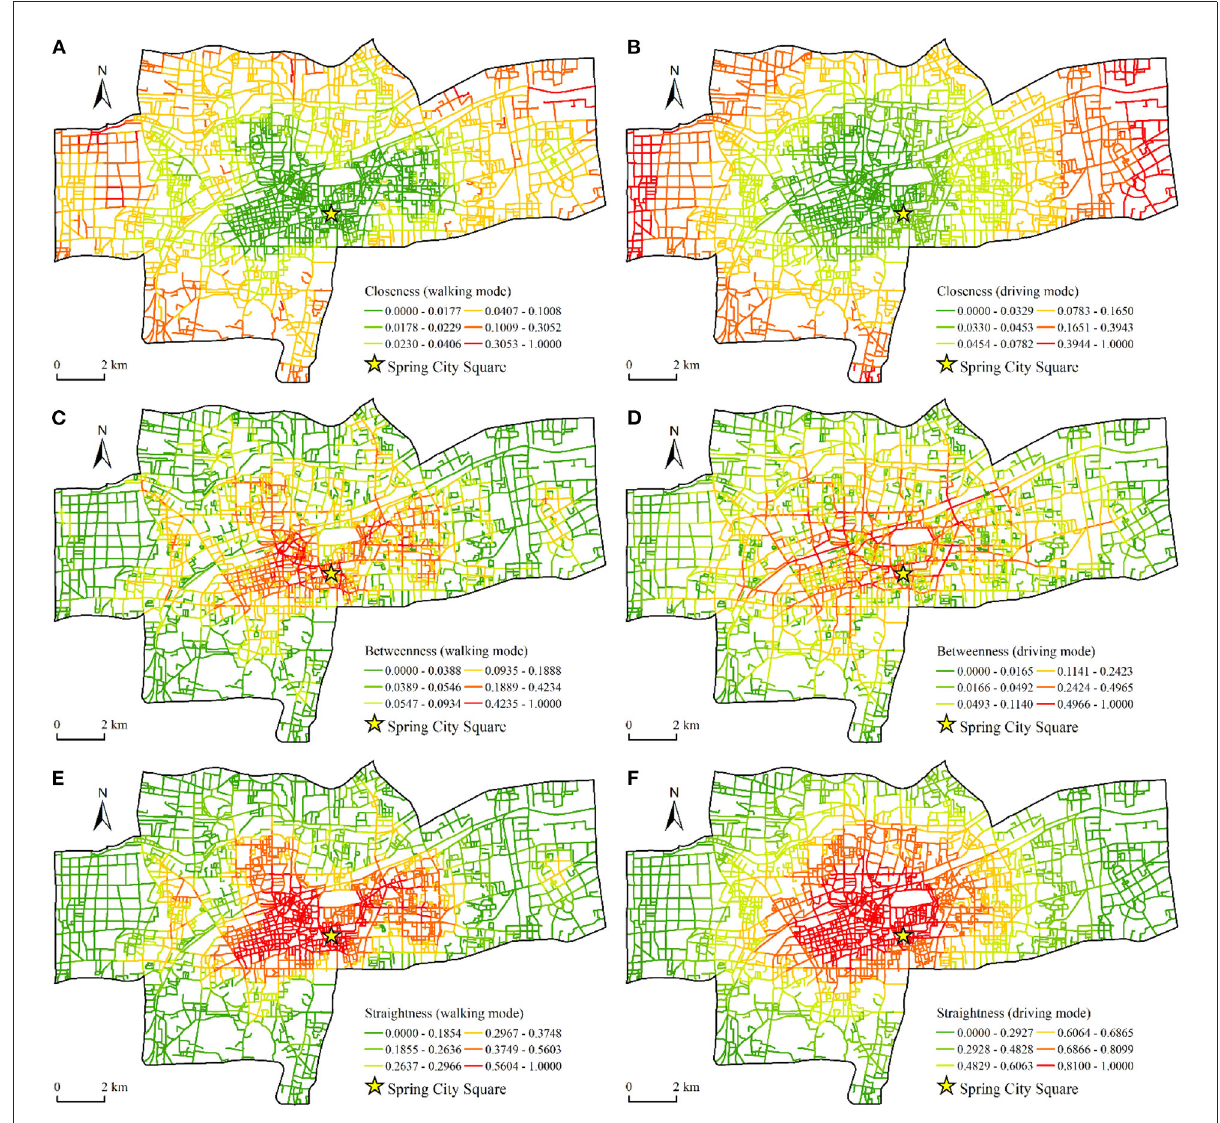
FIGURE3 Spatial pattern of street centrality. (A) Closeness of walking mode. (B) Closeness of driving mode. (C) Betweenness of walking mode. (D) Betweenness of driving mode. (E) Straightness of walking mode. (F) Straightness of driving